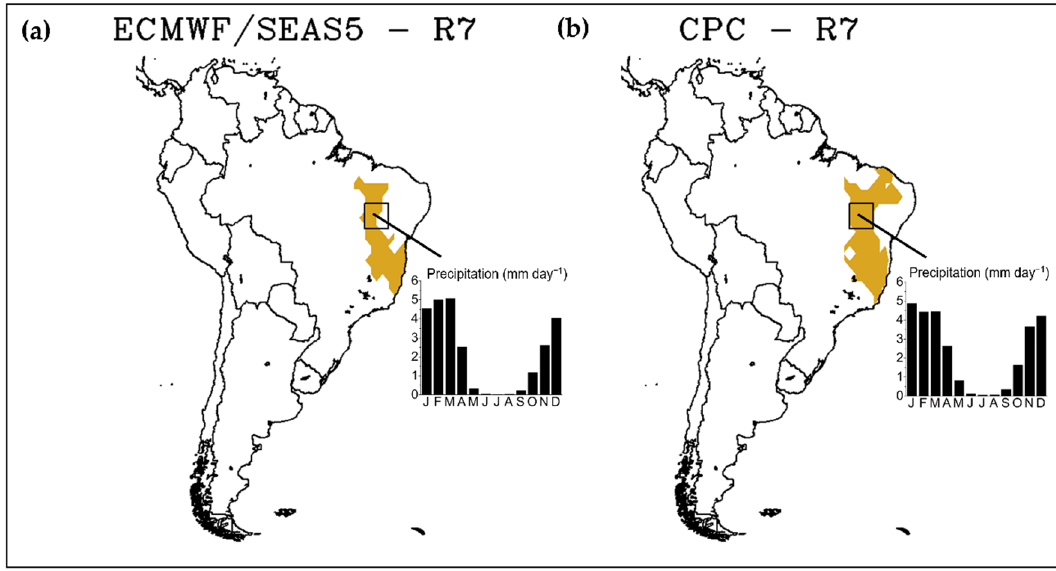
Figure 12. Similar to Figure 6, except for Region 7